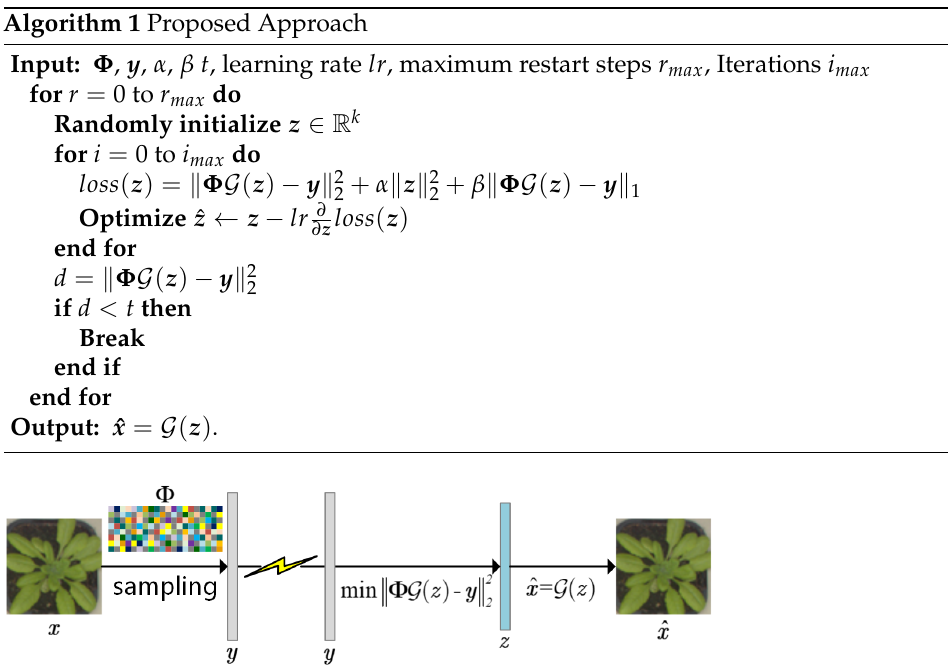
Figure 1. The process of image acquisition based on deep CS. The image sensor compressed samples the original image and transmits the measurements to the base station. The image is reconstructed using the pre-trained generative network G as prior information.